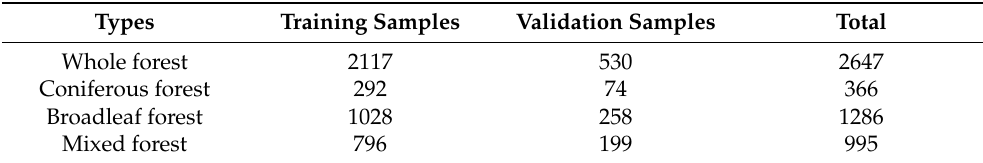
Table 4. The number of training/validation samples corresponding to WF, CF, BF, and MF for model construction (training: validation =